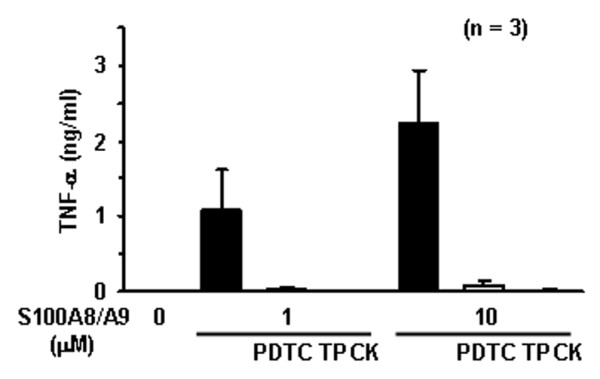
Effects of nuclear factor kappa B (NF-κB) inhibitors on S100A8/A9-mediated cytokine production. Monocytes (1 × 106 cells per ml in culture medium with 10% fetal calf serum), after two-hour pretreatment with or without the inhibitors of NF-κB activation (1 μM), 1-pyrrolidinecarbodithioic acid (PDTC), and Nα-tosyl-phenylalanylchloromethylketone (TPCK), were stimulated for 24 hours with or without S100A8/A9 (1 or 10 μM) in the presence of polymyxin B. Culture supernatants were measured for tumor necrosis factor alpha (TNF-α) concentrations by enzyme-linked immunosorbent assay. Values are the mean ± standard error of the mean. n, number of samples tested.